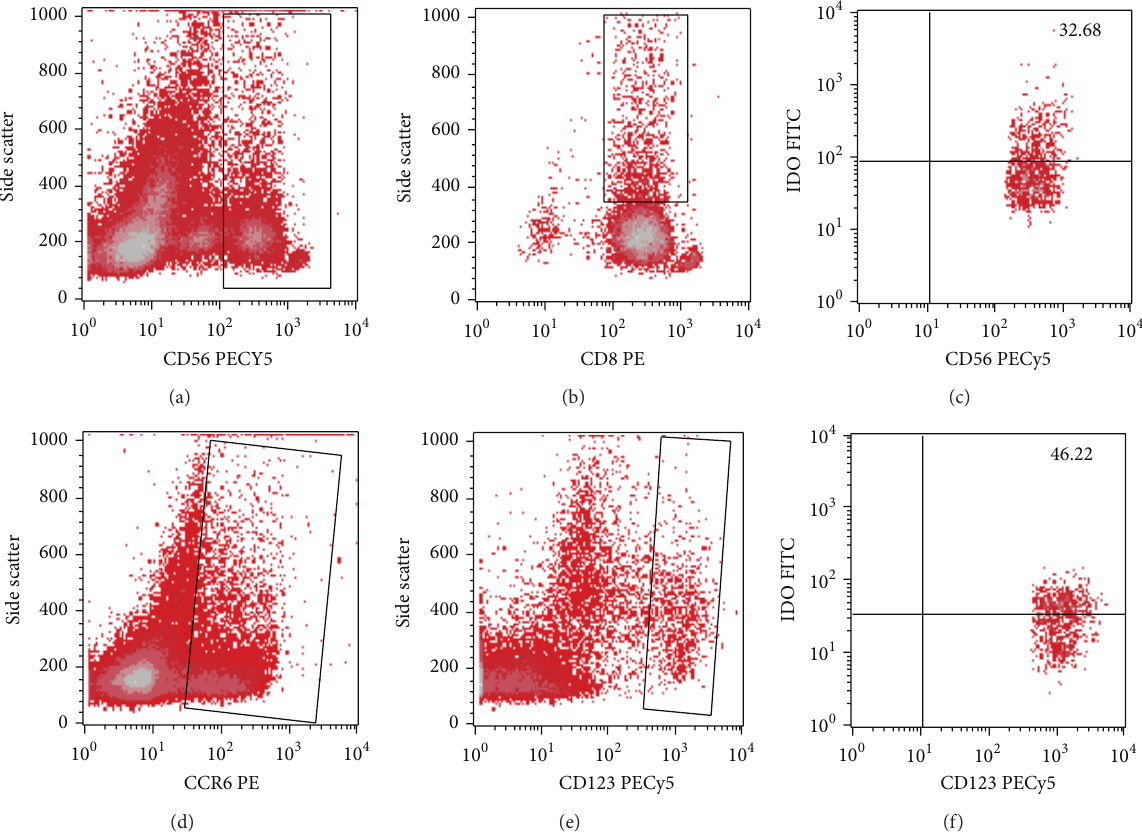
Figure 3: Representative density plots of IDO-expressing circulating cells in IBD (UC and CD) patients. (a) An electronic gate was made for CD56 + cells. (b) From the gate 𝐴 CD56 + /CD8 𝛼 + large granular cells were determined. (c) From the latter CD56 + /CD8 𝛼 + /IDO + cells were defined. (d) An electronic gate was made for CCR6 + cells. (e) From the gate 𝐷 CCR6 + /CD123 + plasmacytoid dendritic cells were determined, and an electronic gate was made for double positive cells. (f) From the latter CCR6 + /CD123 + /IDO + cells were defined. A total of 50,000– 100,000 events were recorded for each sample before any gate setting and analysed with the CellQuest Pro software (BD